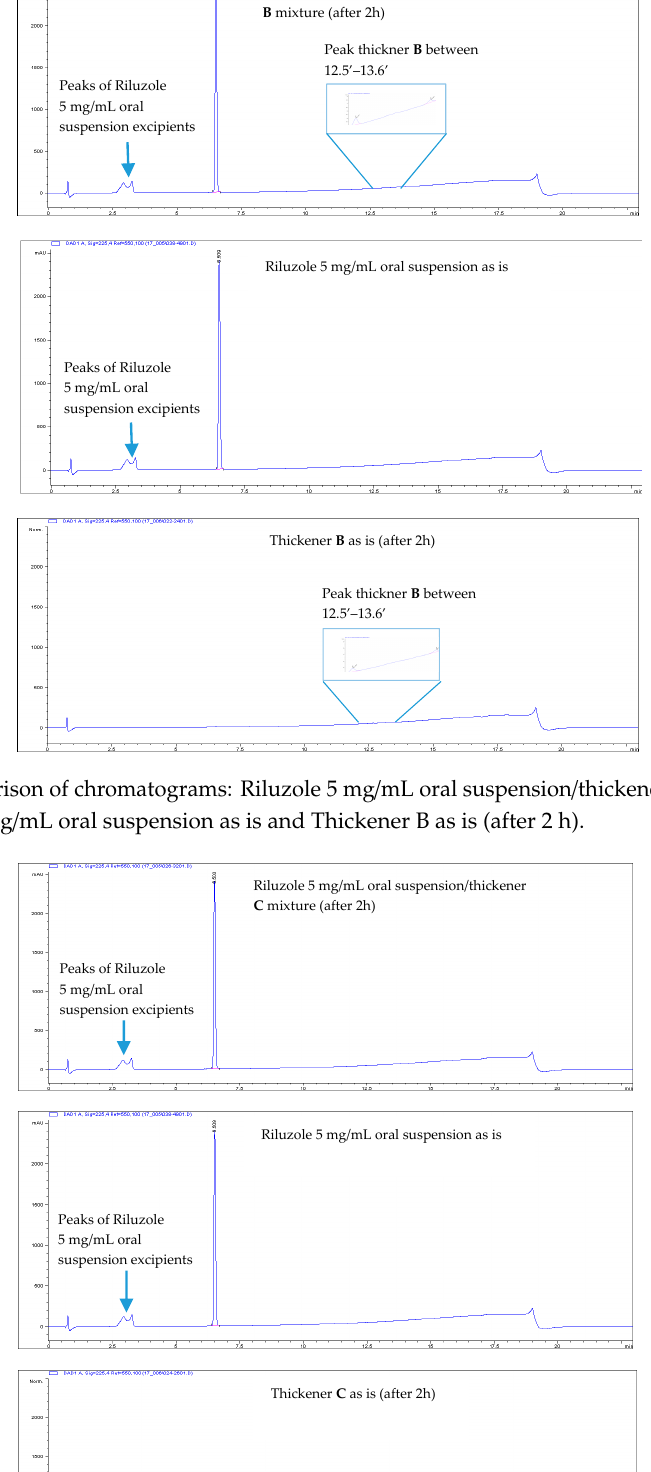
Riluzole 5 mg/mL oral suspension/thickener B mixture (after 2h) Peak thickner B between 12.5’–13.6’